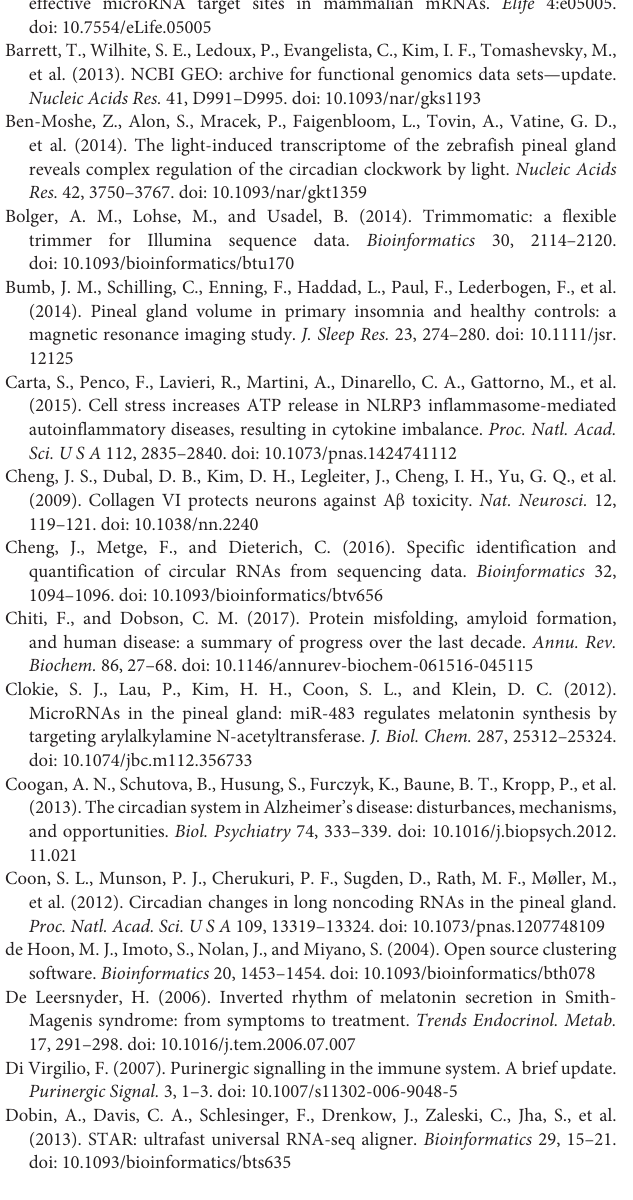
FIGURE S1 | Expression of protein-coding genes of the selected gene groups. (A) Expression changes of the myosin genes. (B) Expression changes of the histone genes. A one-tailed t -test was applied to calculate the P -value ( ∗ < 0.05, ∗∗ < 0.01, ∗∗∗ < 0.001). FIGURE S2 | Measurement of lncRNA and circRNAs level and confirmation of the circular RNA structure. (A) Measurement of lncRNA and circRNAs by PCR.